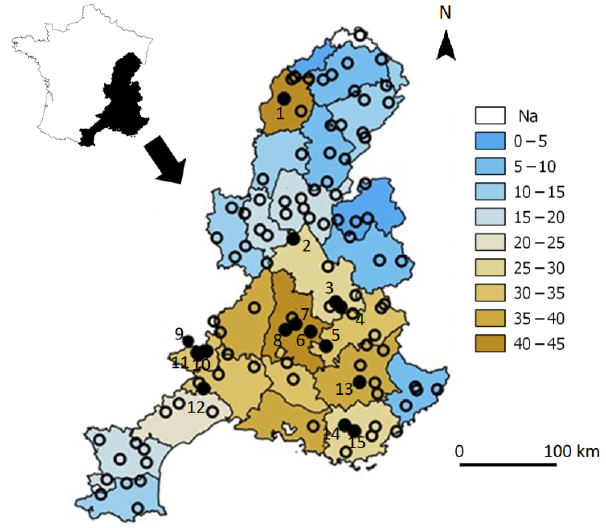
Figure 1. The Rhône–Mediterranean water district, the total num- ber of WR decisions stated by department over the period 2005– 2016 and the gauged catchments ( ◦ ) where WR decisions are simu- lated ( • denotes the subset of the 15 catchments used for evaluation purposes, and the figures are the related ranks presented in Table